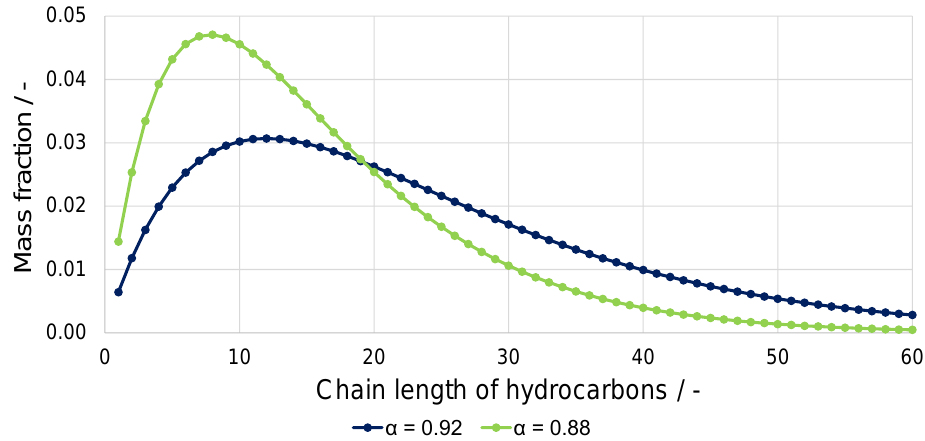
Figure A1. Product distribution of the Fischer–Tropsch synthesis for α = 0.88 and α = 0.92.